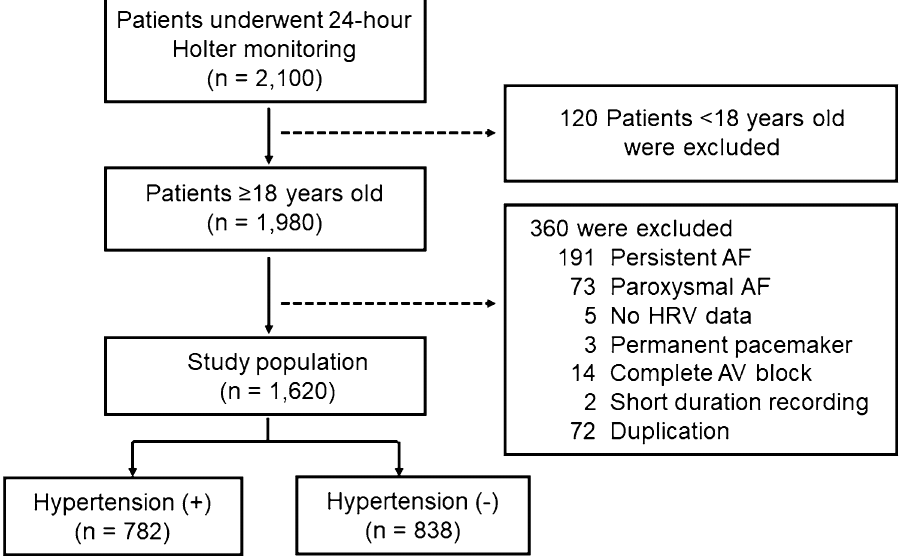
Figure 1. Enrollment of patients in the study. AF, atrial fibrillation; HRV, heart rate variability.